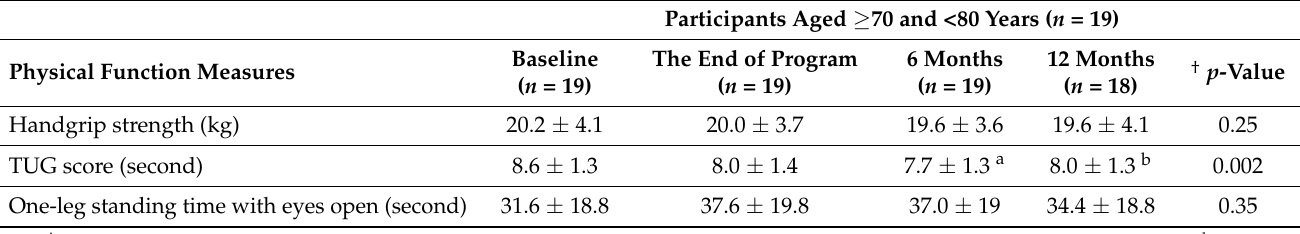
Table 2. Changes in physical function in older participants aged ≥ 70 and <80 years.